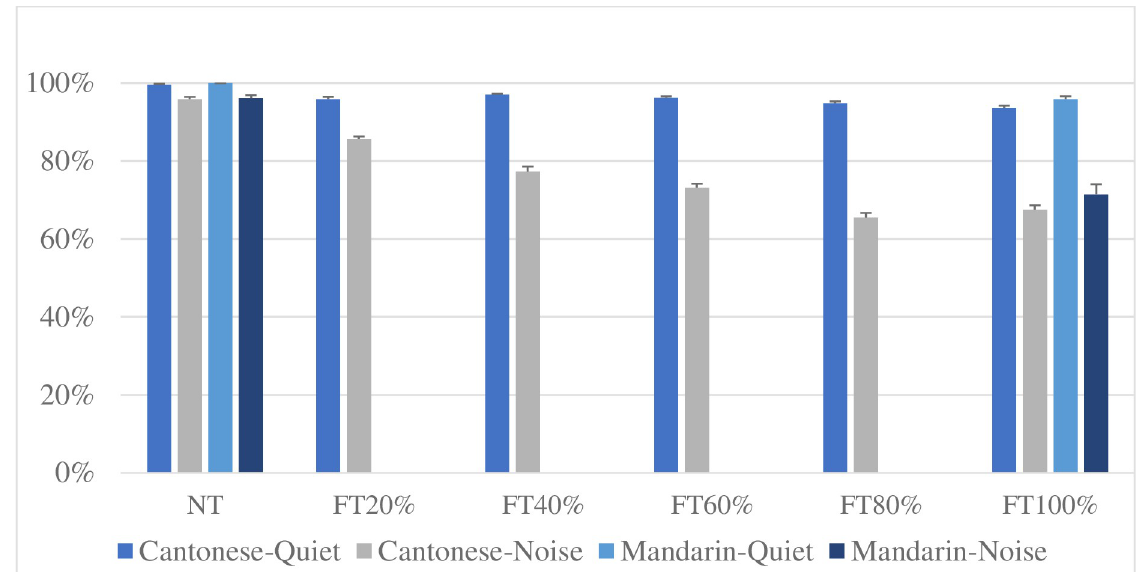
Fig 1. Mean Cantonese and Mandarin sentence recognition scores (percentage of words identified correctly) in quiet and at 0dB SNR with speech-shaped noise. The error bar denotes ± 1 standard error of the mean. NT, FT 20%, FT 40%, FT 60%, FT 80%, and FT 100% represent 0%, 20%, 40%, 60%, 80%, and 100%, manipulation of words in a sentence, respectively. Mandarin sentence recognition scores were obtained from Chen et al. [6].